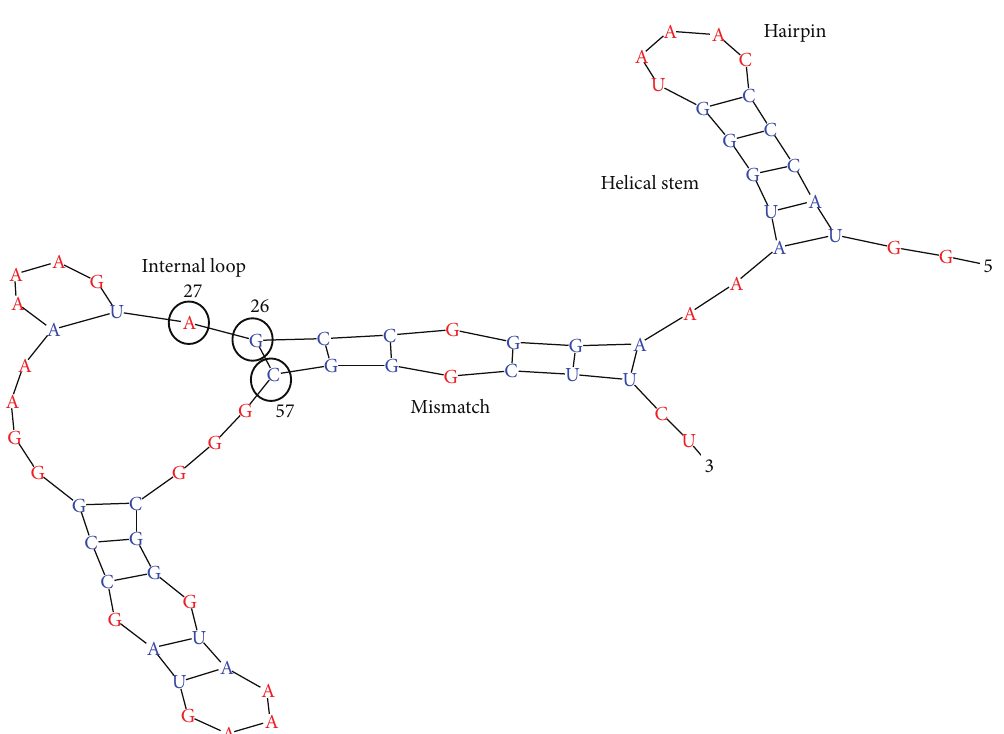
Figure 1: A fragment of the RNA chain with typical elements of secondary